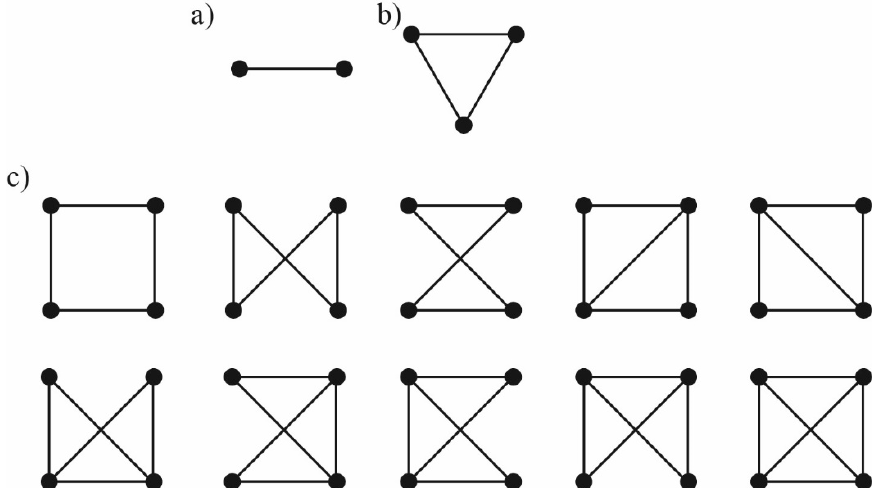
Figure 1. Irreducible diagrams for calculation of the partition function in the necessary order of approximation on particle concentrations. ( a )—linear diagram for calculation of the partition function in the second order on concentrations; ( b )—triangular diagram to calculate the third-order contributions to the partition function; ( c )—the fourth order diagrams allowing obtaining the partition function in the fourth order on concentrations.